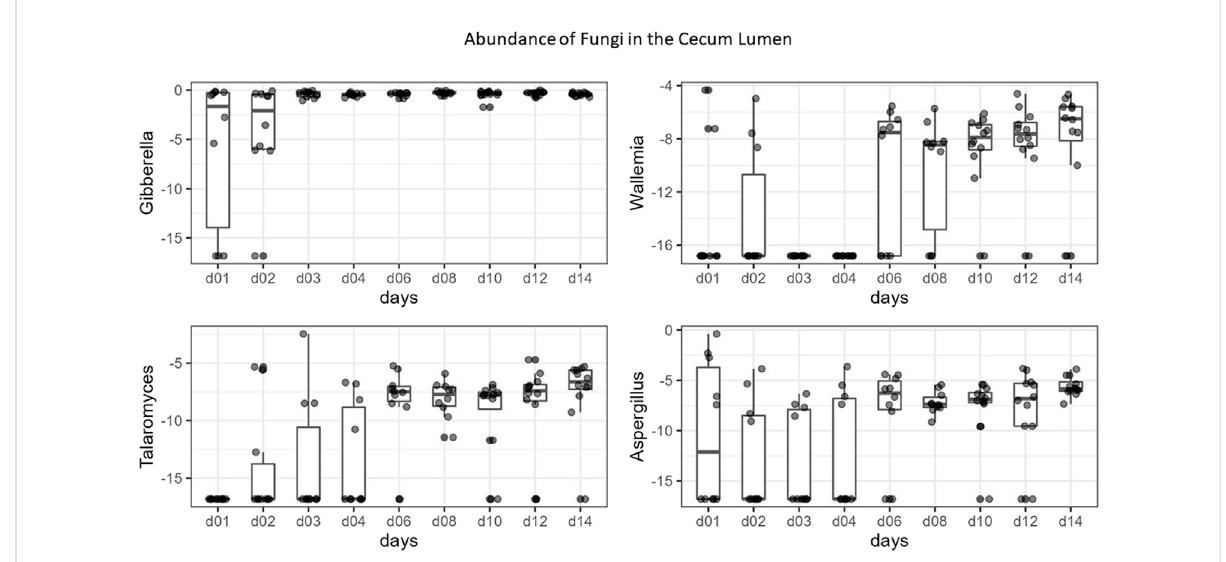
FIGURE 7 Boxplots of the top differentially abundant genera in the cecal lumen across time. Y-axis values are the log base two of relative abundance of each genus, X-axis =